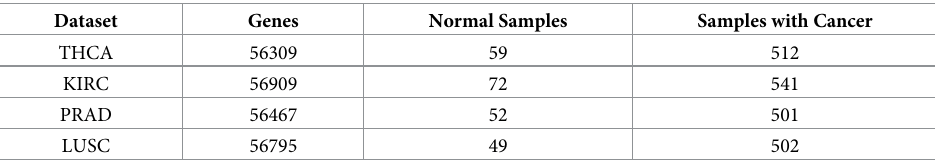
Table 1. Experimental